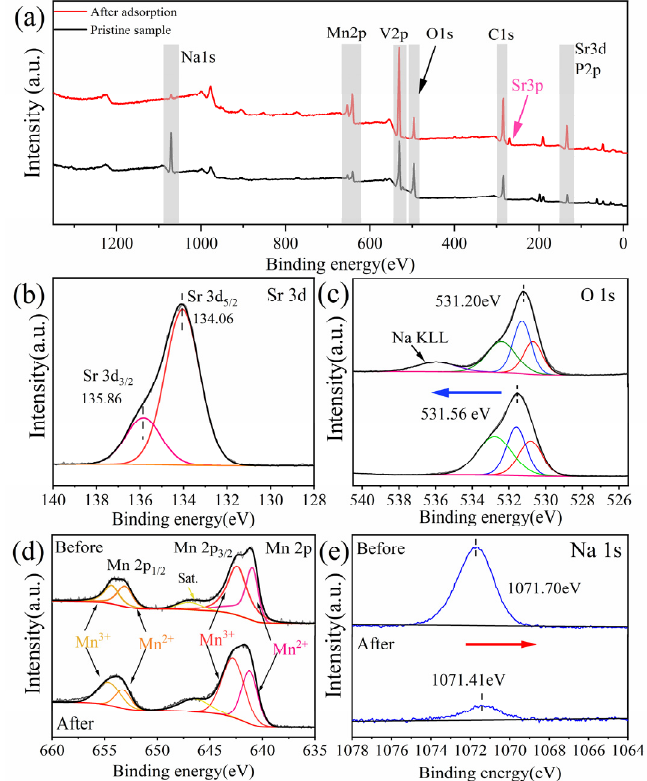
Figure 7. ( a ) XPS full spectrum analysis before and after Sr 2+ adsorption by 1V: 9Mn NVP@NMP ( b ) High-resolution XPS spectrum analysis of Sr 3d region; ( c ) O 1s high-resolution XPS spectrum before and after adsorption; ( d ) Mn 2p region; ( e ) Na 1s region.